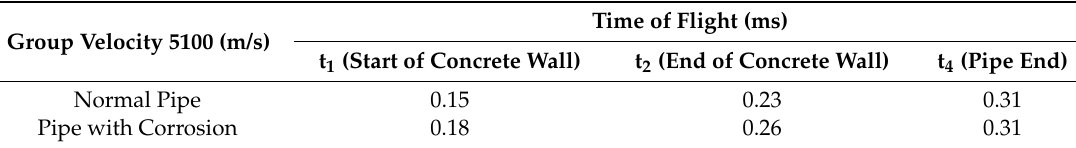
Table 1. Calculated time of flights for critical positions in the concrete-covered pipes.